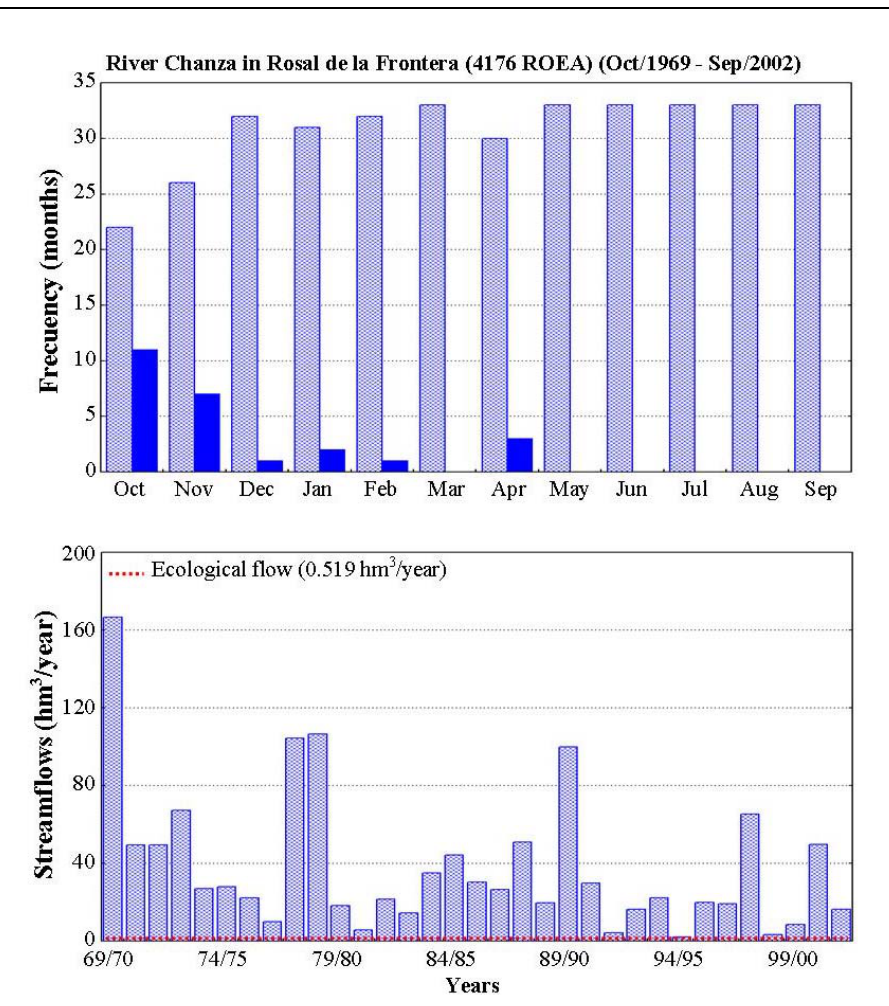
Figure 4. Frequency analysis of the months in which the streamflows were higher (light blue) or lower (dark blue) than the ecological flow requirements identified by the Hydrological Plan of the Guadiana Hydrographic Demarcation (Table 5) and time series of annual streamflows at the gauging station “River Chanza in Rosal de la Frontera” (4176 ROEA; Guadiana tributary) [17].